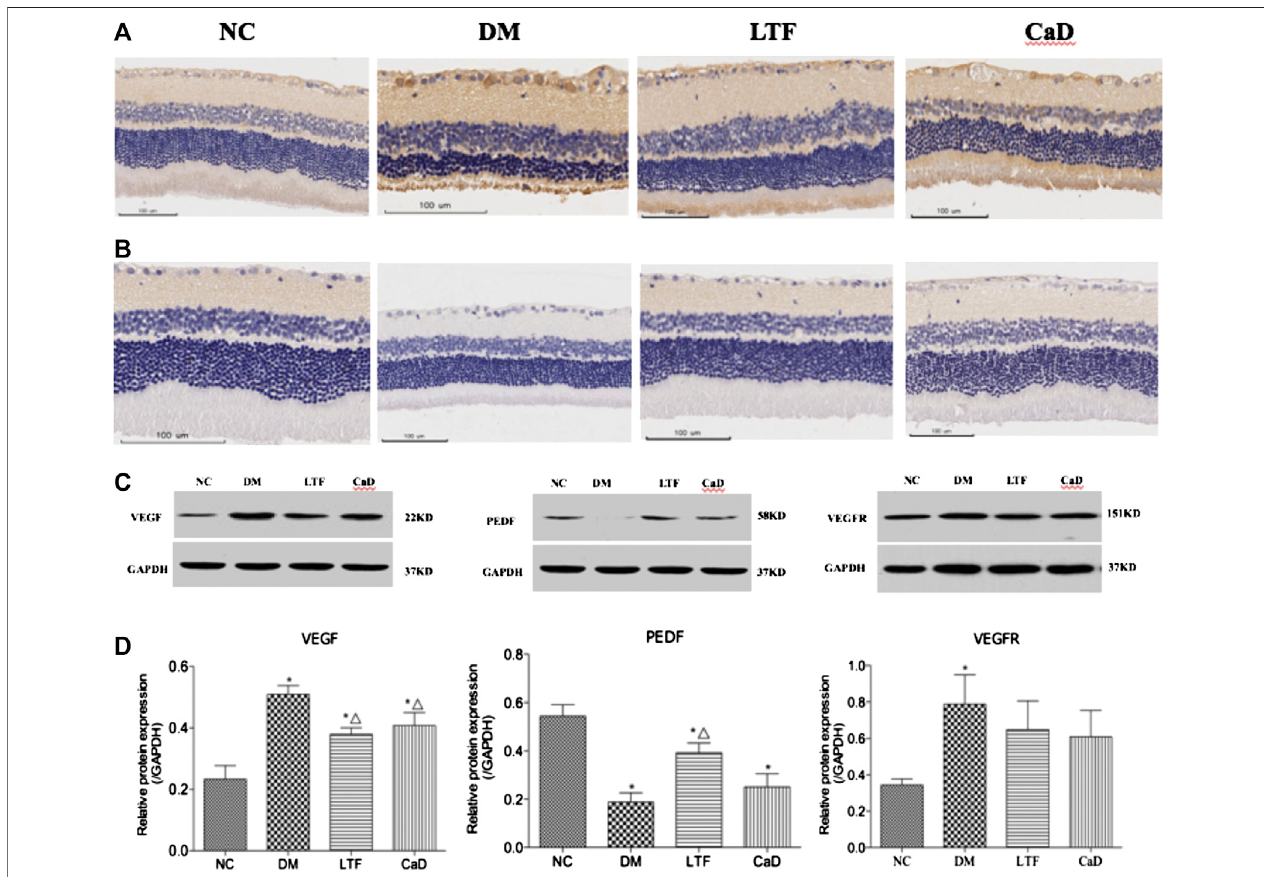
FIGURE 7 | Effect of LTF and CaD on the VEGF, VEGFR and PEDF. (A) Immunostaining of retinal VEGF (400 × magni fi cation); (B) Immunostaining of retinal PEDF (400 × magni fi cation); (C, D) Western blot and quantitative measurement of retinal VEGF, PEDF and VEGFR. Data are mean ± SD from six rats per group, and the experiments were repeated independently four times. (* p < 0.05: vs. NC group; △ p < 0.05: vs. DM group).